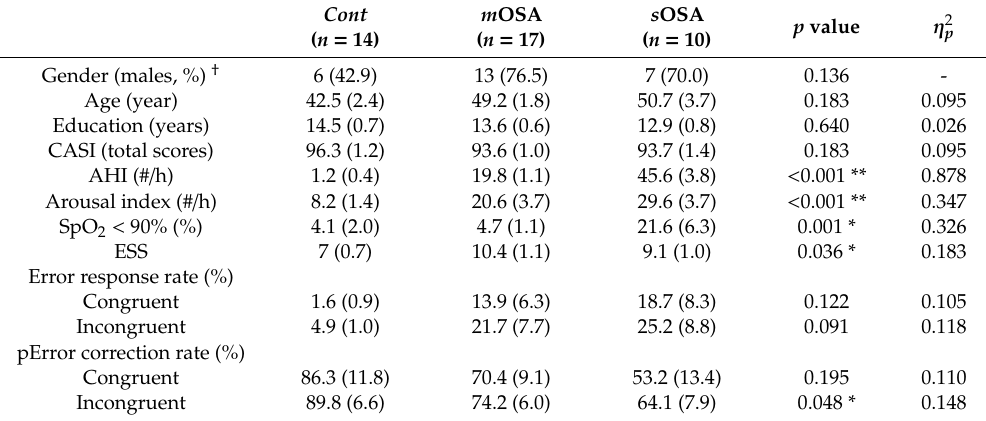
Table 1. Demographic information, polysomnography parameters, and performance on the modified Flanker task in the three study